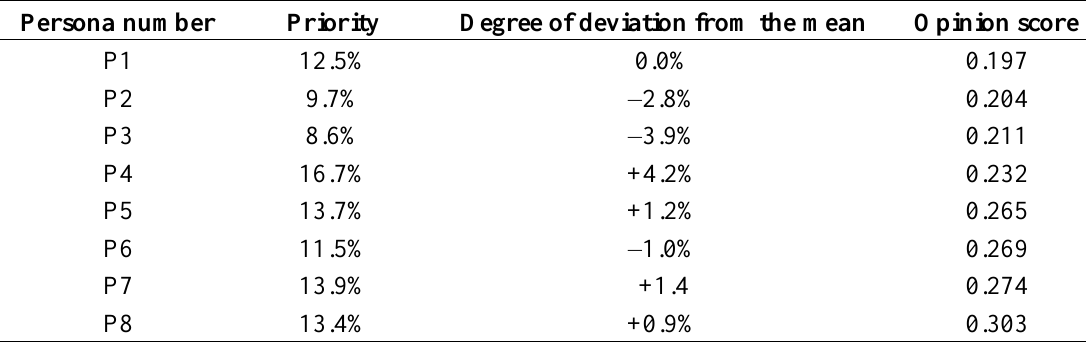
Table 5. Priority of each persona and their opinion score.